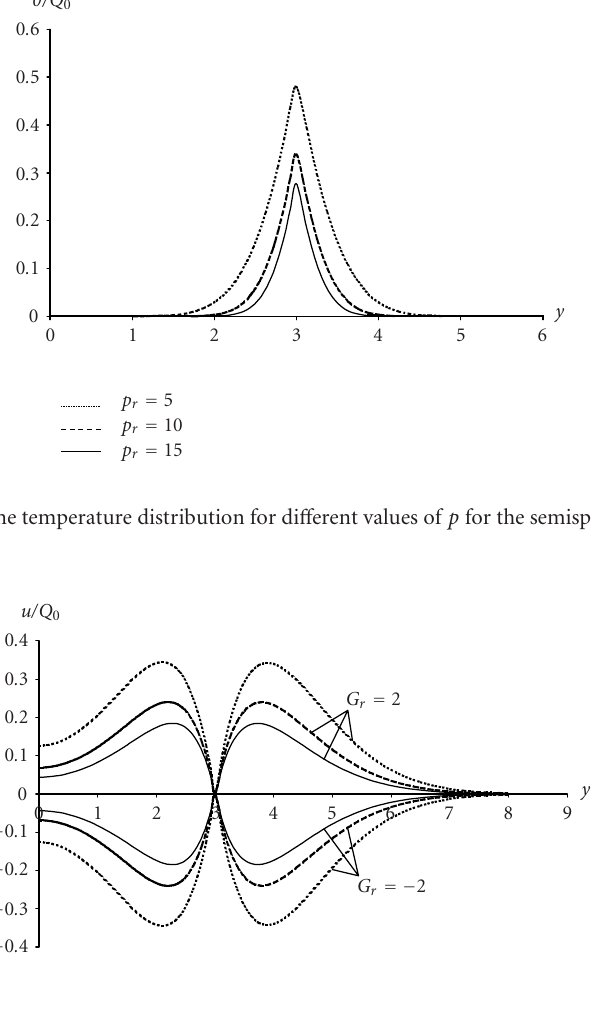
(v) The important phenomenon observed in all computations is that the solution of any of the considered functions vanishes identically outside a bounded region of space surrounding the heat source at a distance from it equal to y ∗ ( t ). Say y ∗ ( t ) is a particular value of y depending only on the choice of t and is the location of the wave front. This demonstrates clearly the di ff erence between the